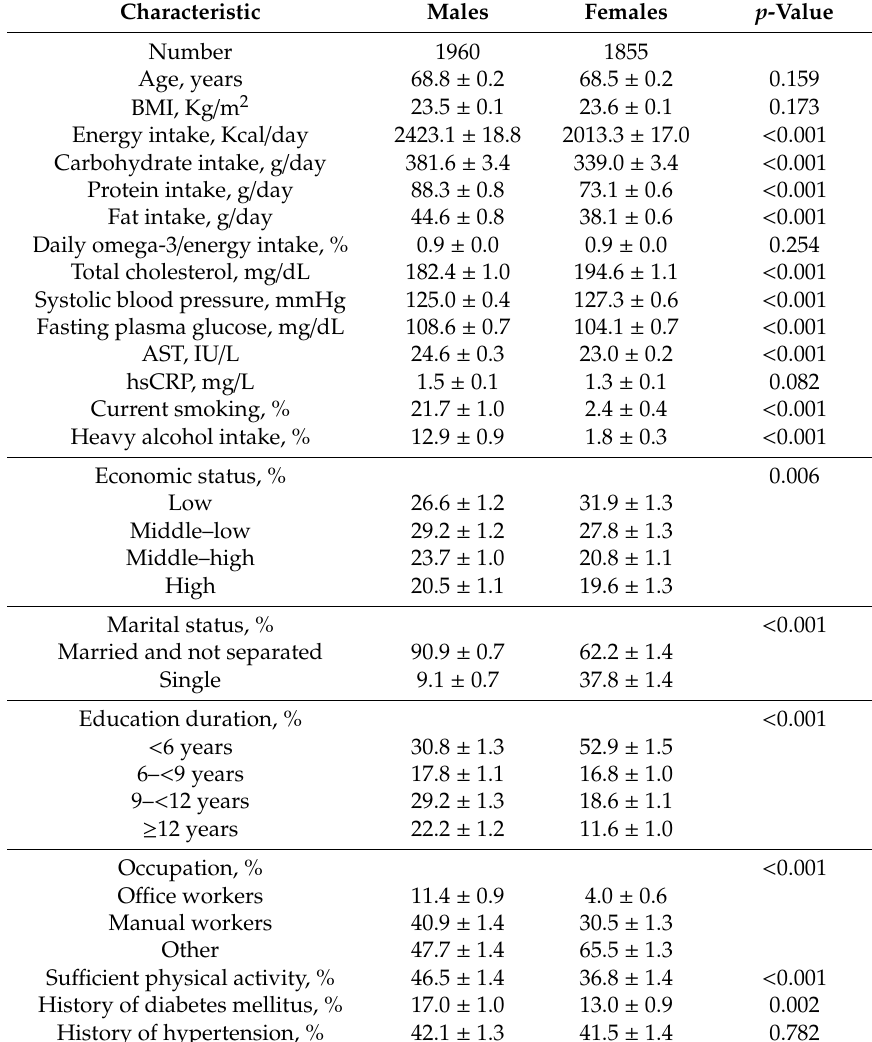
Table 1. Population characteristics according to